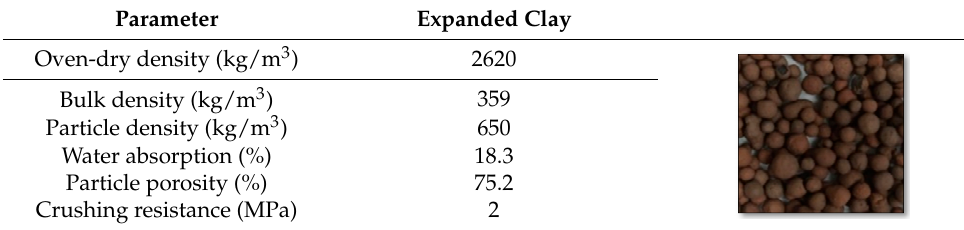
Table 2. Properties of LWA.